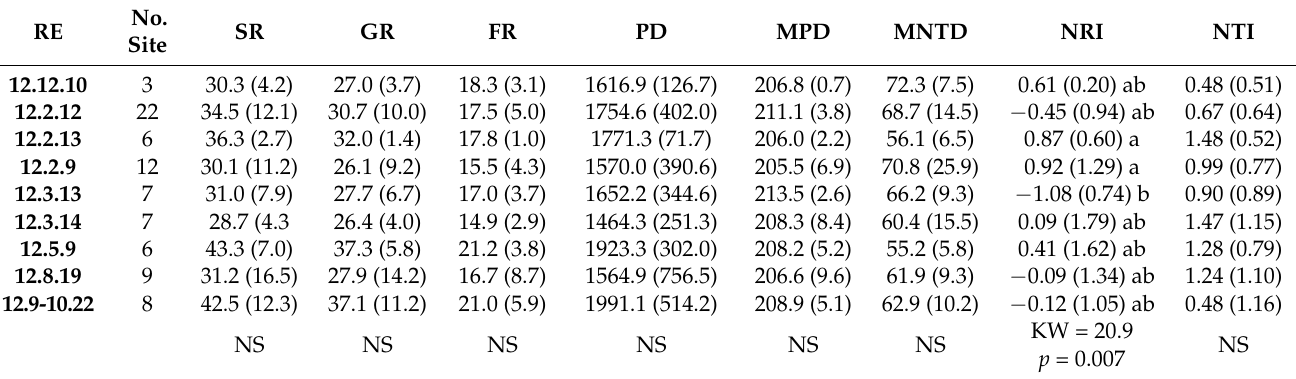
Table 2. Summary of mean diversity values of the Sunshine Coast heath sites grouped by re- gional